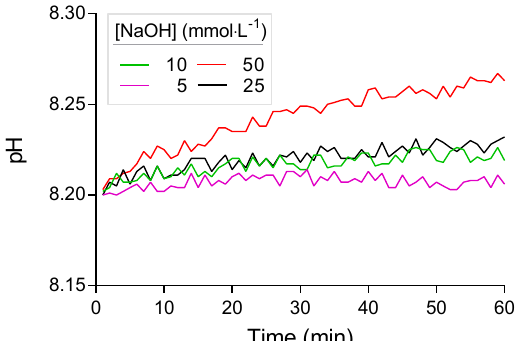
Figure 2. pH drift in artificial seawater over time with different concentrations of NaOH titrant due to diffusion from the titration tip.